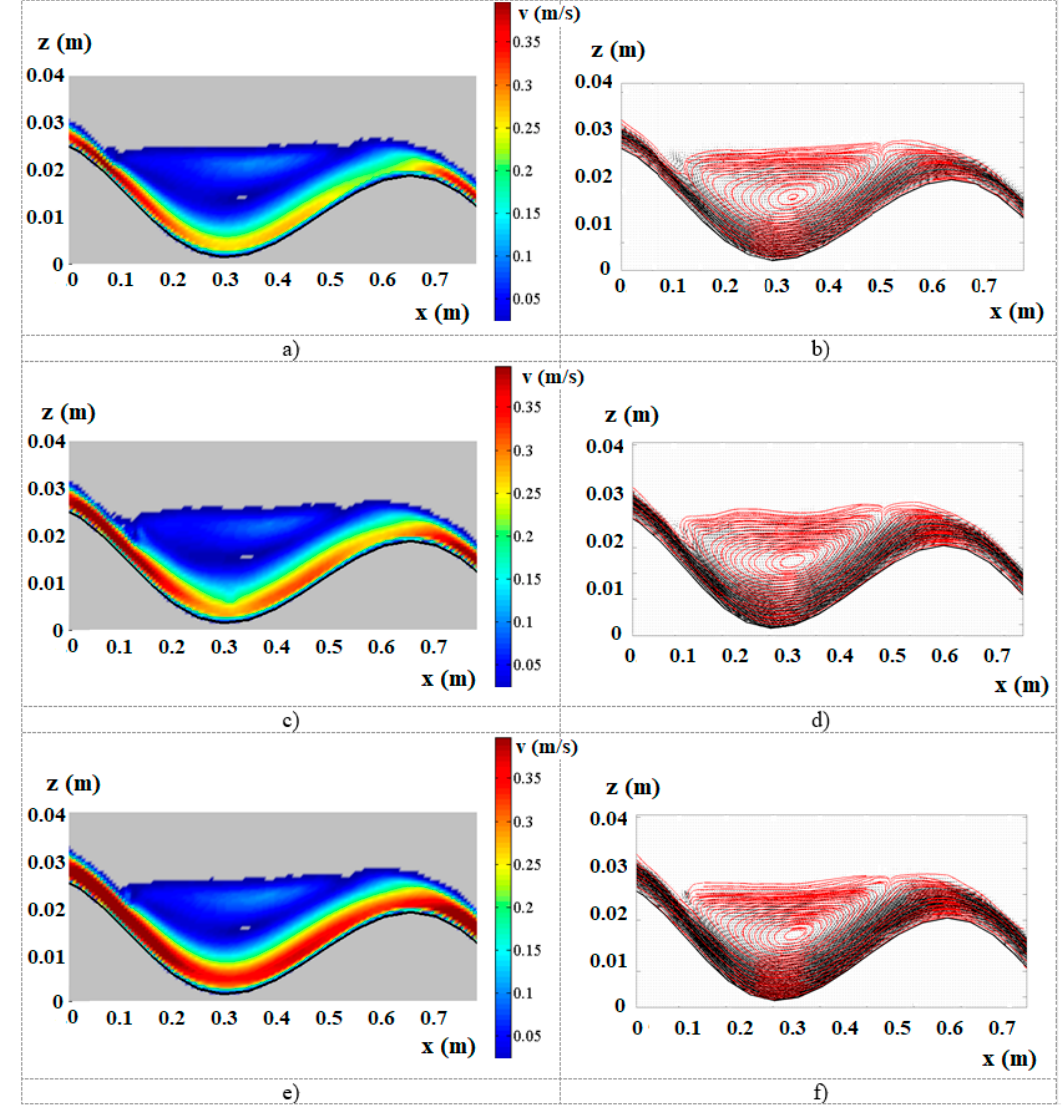
Figure 3. Computational fluid dynamic (CFD) colormap results for 6° slope and flow rate per unit width ( a ) q 1 , ( b ) q 2 , and ( c ) q 3 . Streamlines at flow rate per unit width ( d ) q 1 , ( e ) q 2 , and ( f ) q 3.